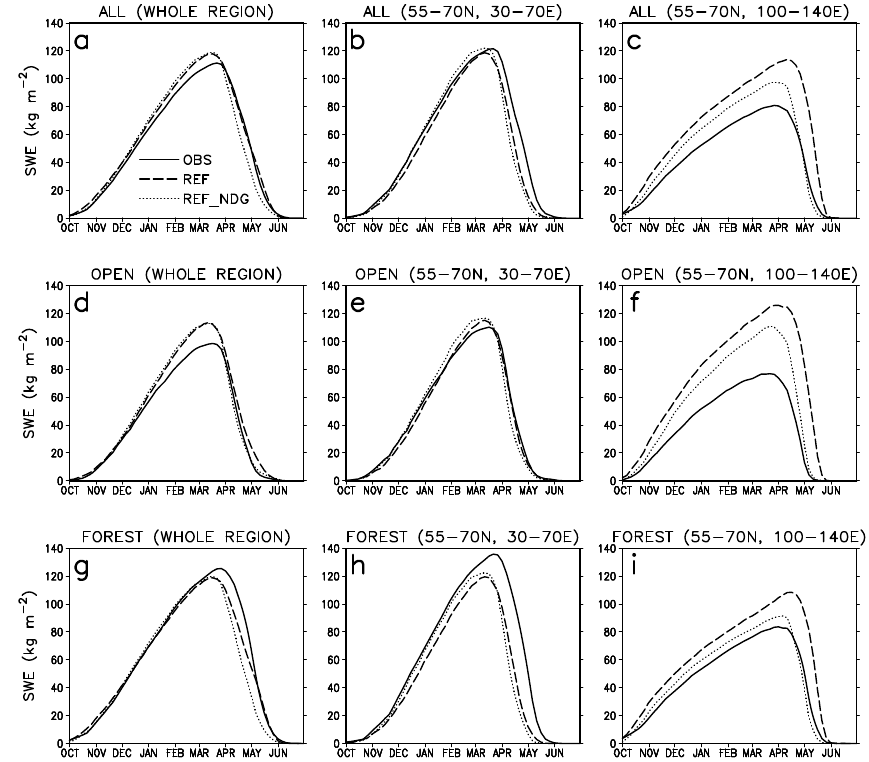
Figure 8. Mean annual cycle of SWE according to the snow course measurements (solid line), in the REF experiment (dashed line) and in the REF_NDG experiment (dotted line) for (a) all snow courses for the whole northern Eurasian domain, (b) for western Russia (55–70 ◦ N, 30–70 ◦ E) and (c) for eastern Siberia (55–70 ◦ N, 100–140 ◦ E). (d – f) as (a – c) but including only open-terrain snow courses. (g – i) as (a – c) but including only forest snow courses. Only those ECHAM5 grid cells with snow course data are included in the domain-mean values. For clarity, results for the ALB1, ALB2, ALB1_NDG and ALB2_NDG experiments are not shown. In general, albedo changes had little effect on SWE, except for the snowmelt